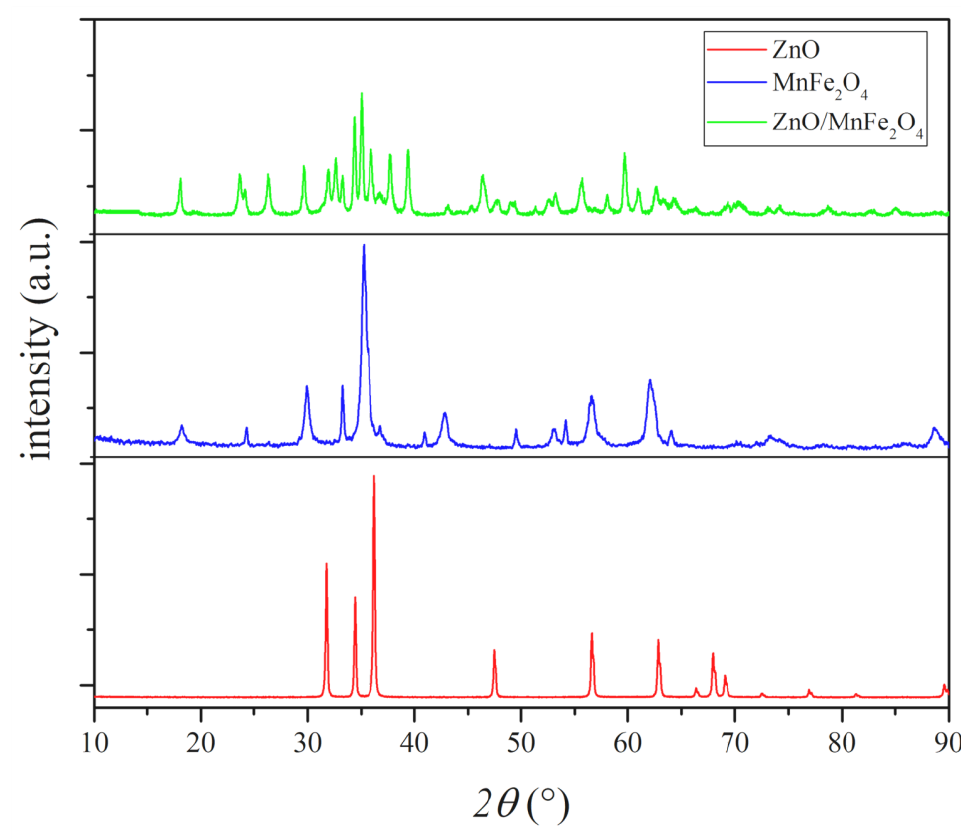
Figure 3. Diffractograms of the materials synthesized.